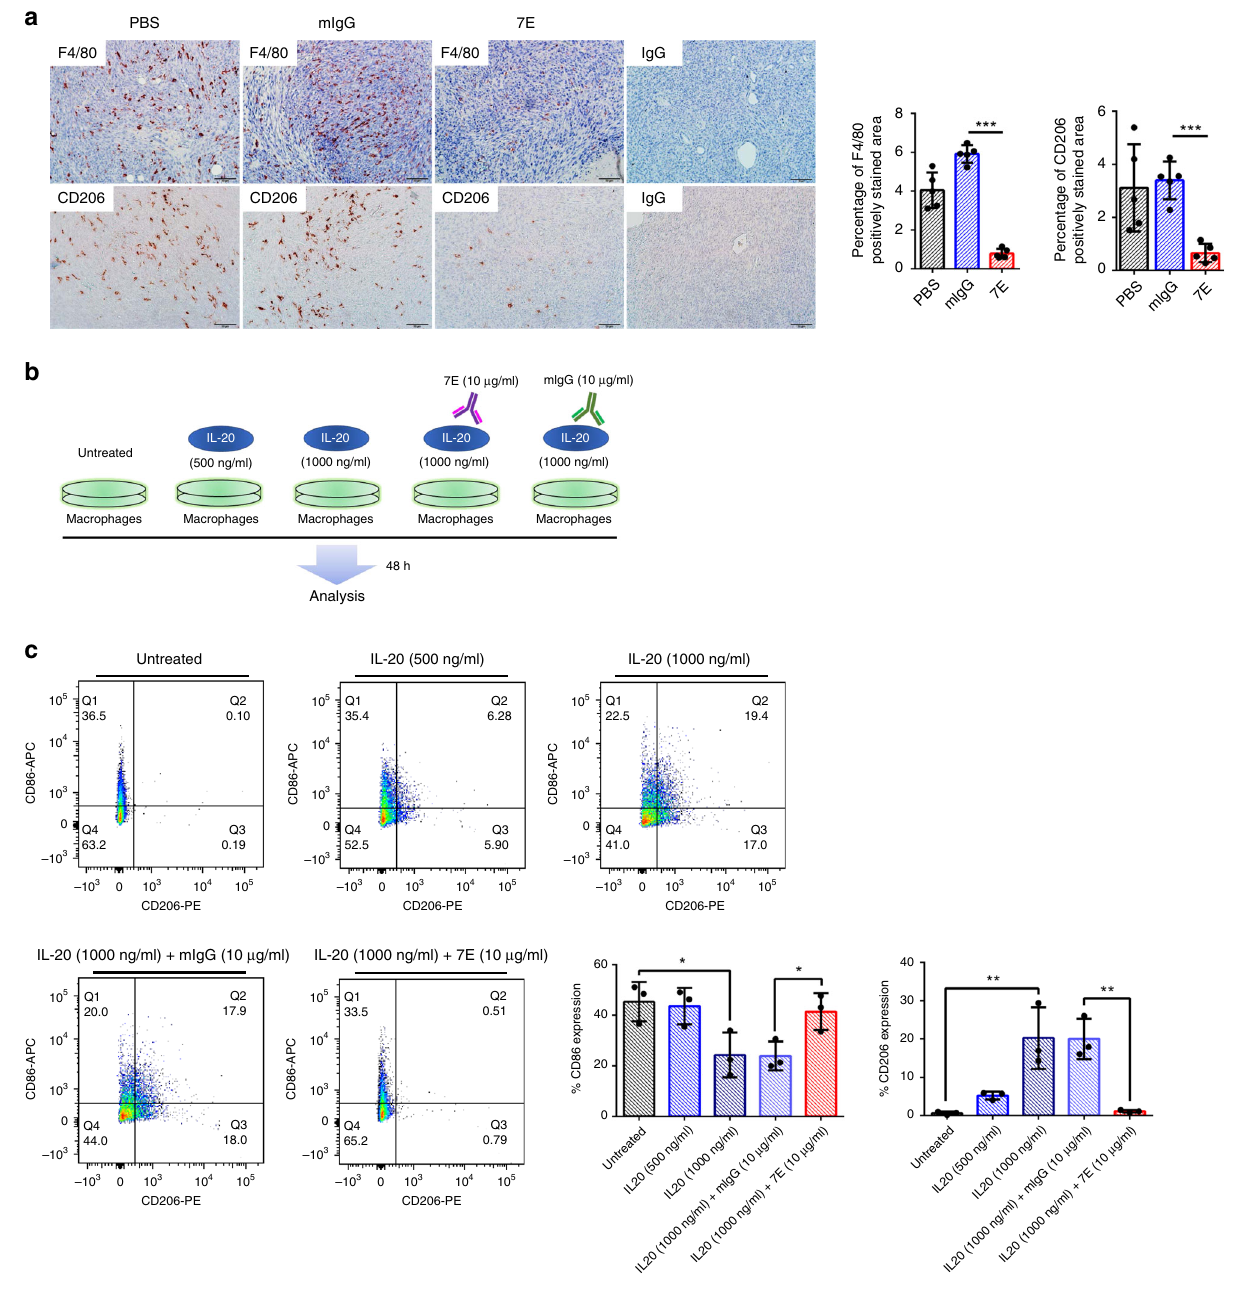
Fig. 3 7E decreased macrophage in fi ltration in an orthotopic model of pancreatic cancer. KPC cells were injected into the pancreas of mice. PBS, mIgG, or 7E treatment was performed ( n = 5), and tumors were harvested at day 28. a IHC staining for F4/80 (one-way ANOVA, p = 0.0131) and CD206 (one-way ANOVA, p < 0.0001) counterstaining in a tumor tissue sample. Immunohistochemical quanti fi cation with the HistoQuest software (right) demonstrated a reduction in in fi ltrating macrophage numbers in the tumor ( n = 5). Original magni fi cation: ×200; scale bar, 50 μ m. The rightmost panel shows the IgG- stained negative control. *** p < 0.001 compared with the mIgG-treated controls. b Flowchart of treatment. BMDMs were treated with IL-20 for 48 h, and 7E was used to neutralize the activity of IL-20. c The number of CD206 (one-way ANOVA, p = 0.0003) and CD86 (one-way ANOVA, p = 0.0089) in macrophages was determined by fl ow cytometry. The results in the bar graph (right) represent the average value of three independent experiments. * p < 0.05, ** p < 0.01. Data are presented as mean ± SD. Statistical signi fi cance was determined by one-way ANOVA Sidak ’ s multiple comparisons test ( a , c fat loss in the LLC-induced CAC model via inhibition of lipolysis. Increased lipolysis is associated with activation of the lipolytic enzymes HSL and ATGL in adipose tissue 46,47 . 7E treatment signi fi cantly reduced CAC-induced HSL and ATGL gene expression in epididymal fat following LLC cell inoculation (Fig. 7a, b). IHC staining con fi rmed that the increased number of HSL-positive cells in the epididymal fat of tumor-bearing mice